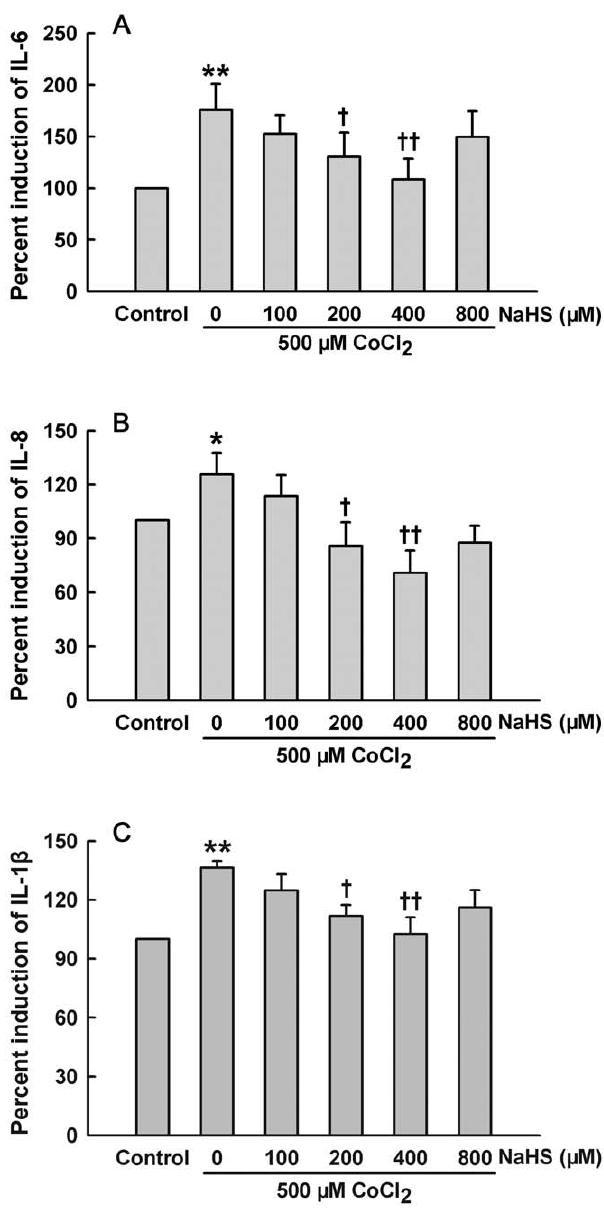
Figure 3. H 2 S inhibits CoCl 2 -induced IL-6, IL-8 and IL-1 b secretions from HaCaT cells. HaCaT cells were exposed to 500 m M CoCl 2 for 24 h in the absence or presence of pretreatment with NaHS at the indicated concentrations for 30 min. ELISA was performed to detect the levels of IL-6 ( A ), IL-8 ( B ) and IL-1 b ( C ) in cell supernatants. Data were shown as the mean 6 SE. * P , 0.05, ** P , 0.01 compared with control group. + P , 0.05, ++ P , 0.01 compared with CoCl 2 treatment group.